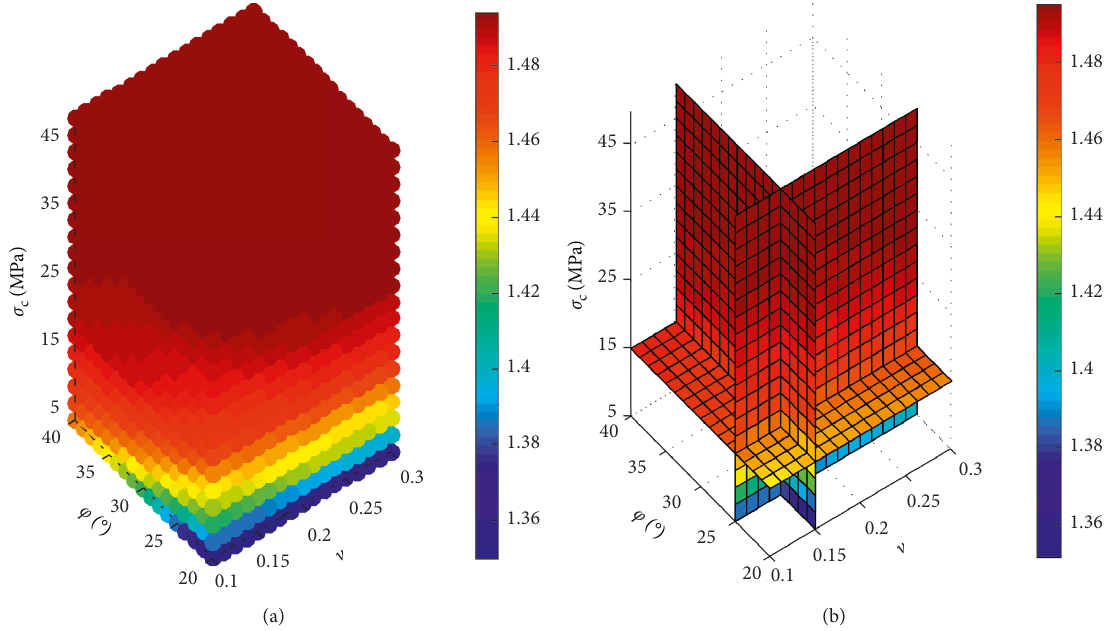
Figure 10: Interpolation of the unloading coefficient n for E